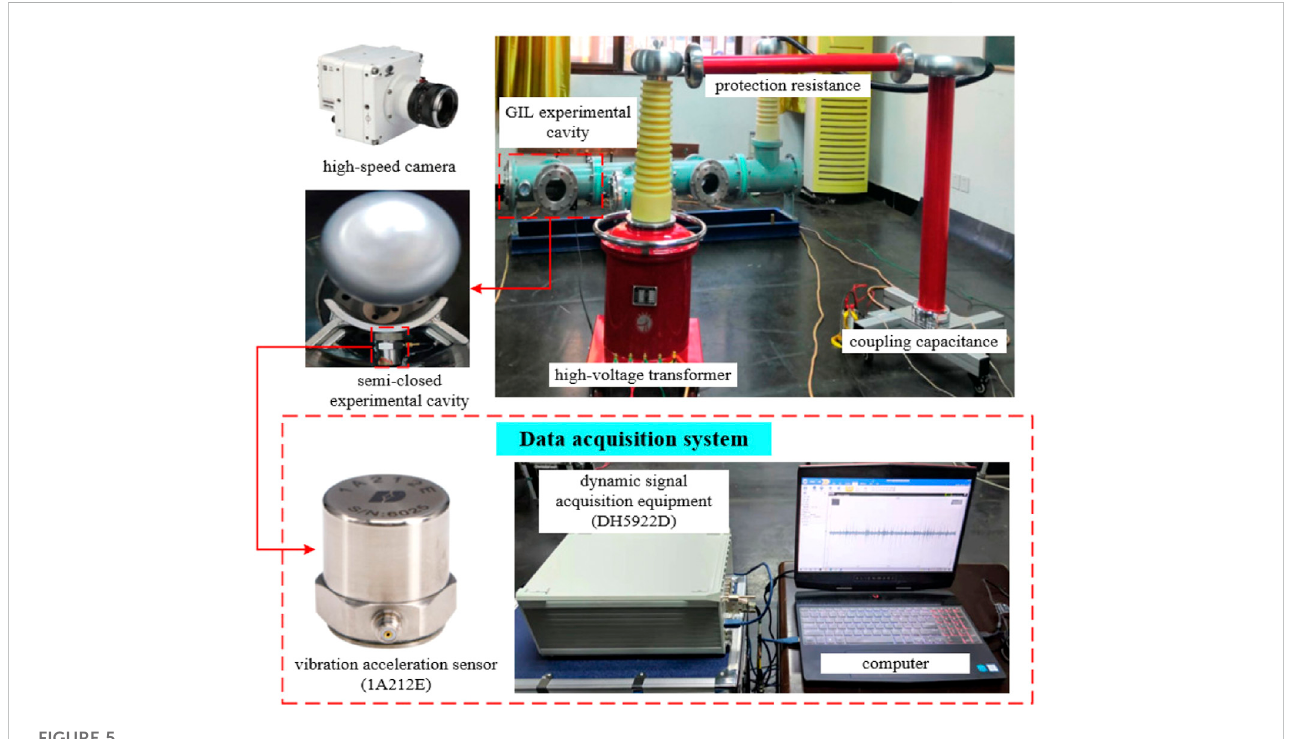
FIGURE 5 High-voltage GIL experimental platform.